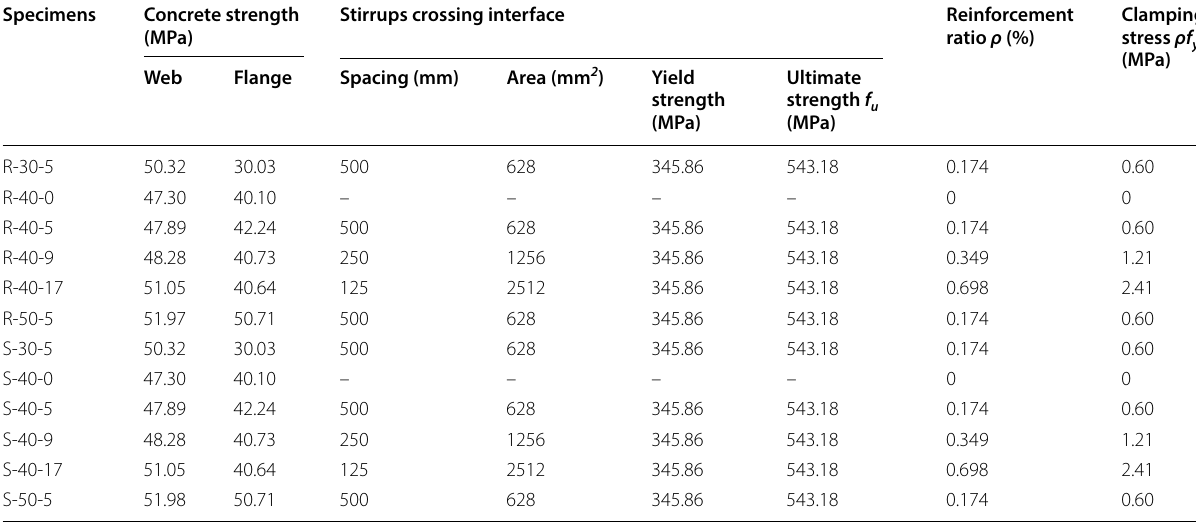
Table 2 Detail properties of test beams.